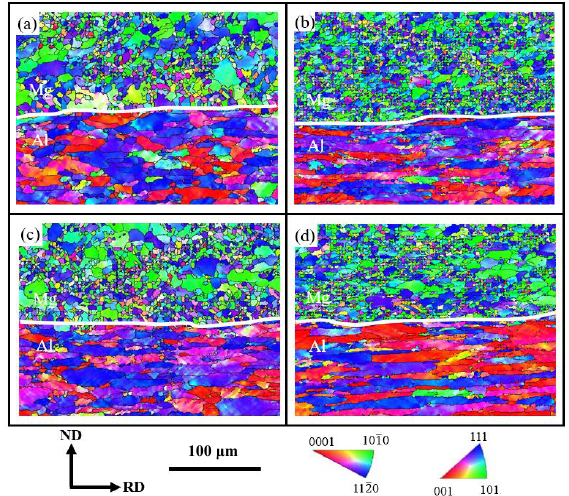
Figure 5. Interface IPF images of the corrugated Mg/Al clad sheet: ( a ) front waist; ( b ) peak; ( c ) back waist; ( d ) trough.